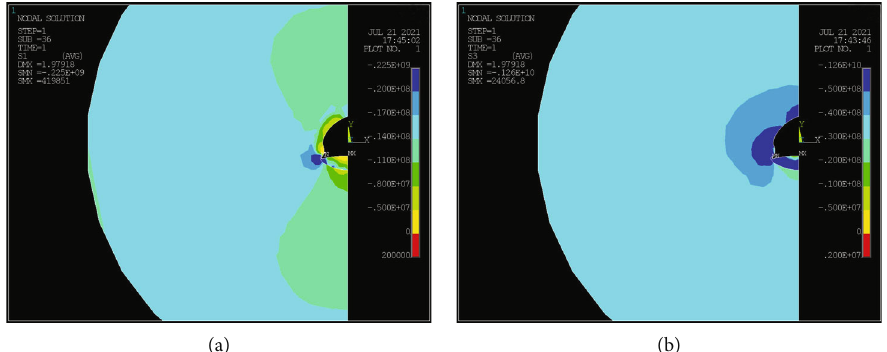
σ Figure 11: Maximum ( σ 1 ) (a) and minimum ( 3 ) (b) principal stresses around the roadway with a solution model